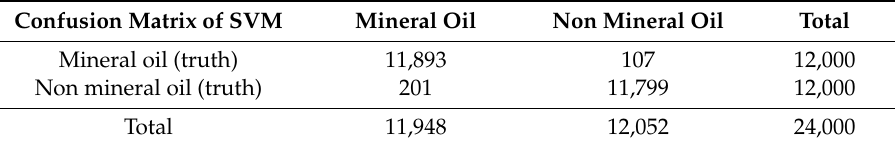
Table 10. SAE Confusion Matrix (20,000 training, 4000 testing, six-fold) derived by